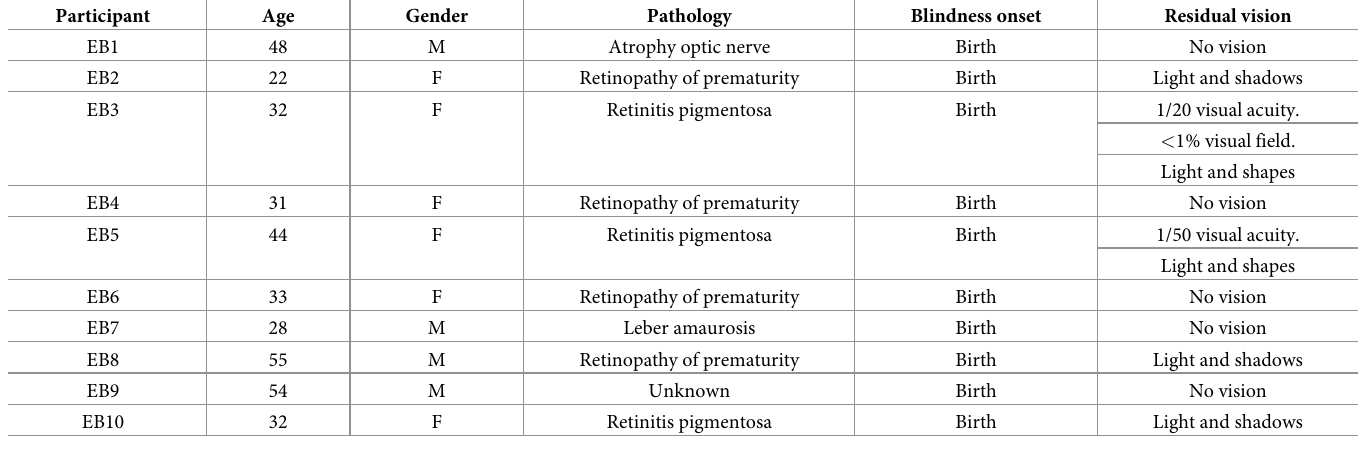
Table 1. Clinical details of early blind